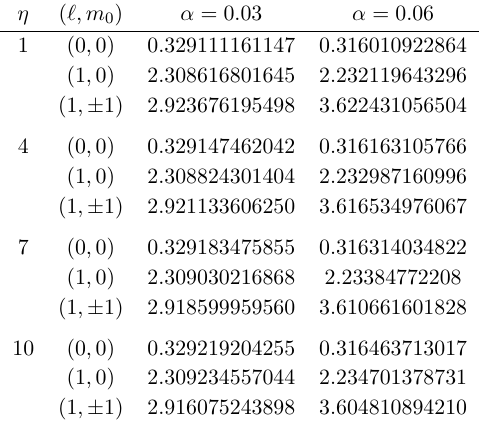
Table 11 . Angular eigenvalues λ of the ARNAdS black hole with 3 r h = Λ = − 3 . Open